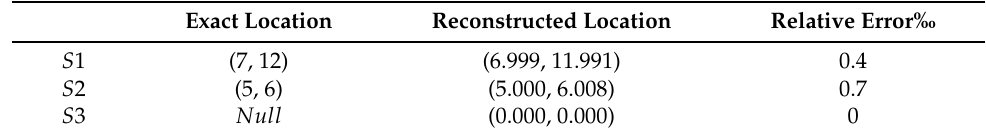
Table 5. Reconstruction of the number of